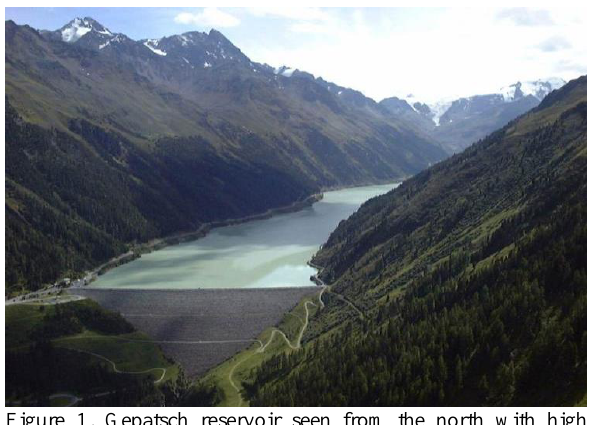
Figure 1. Gepatsch reservoir seen from the north with high water level (image © www.kaunergrat.at ).